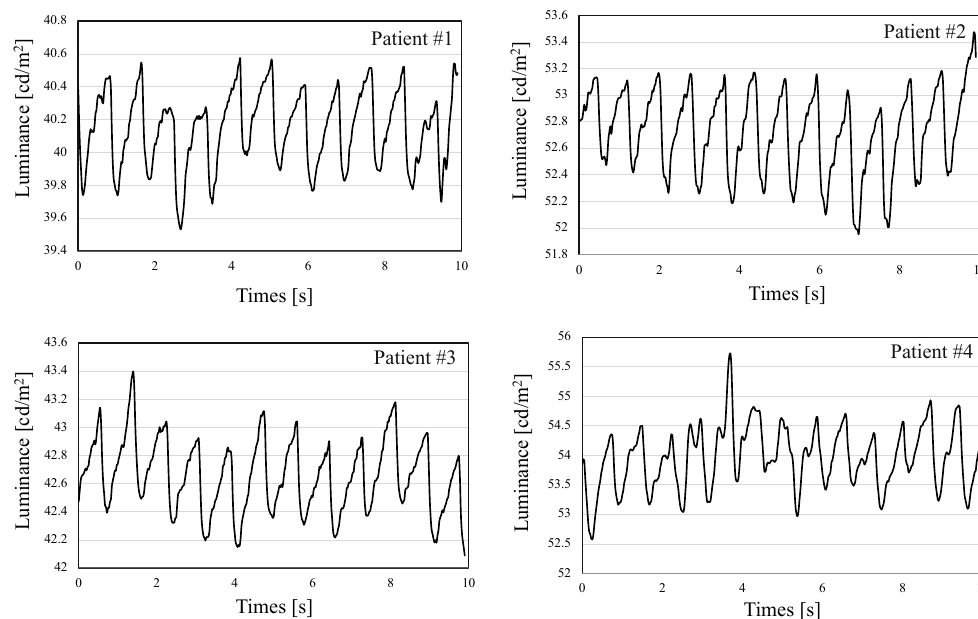
Figure 14. Typical examples of AVF pulse wave measurement with optimal kernel N =